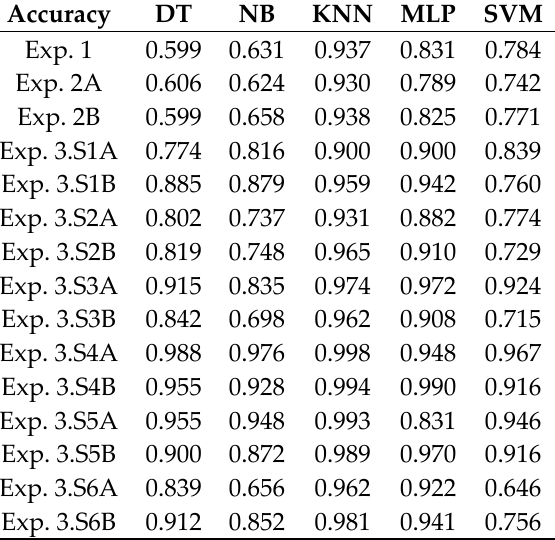
Table 4. Classification accuracy obtained per each experimentation in each classification algorithm by using a 10-fold cross